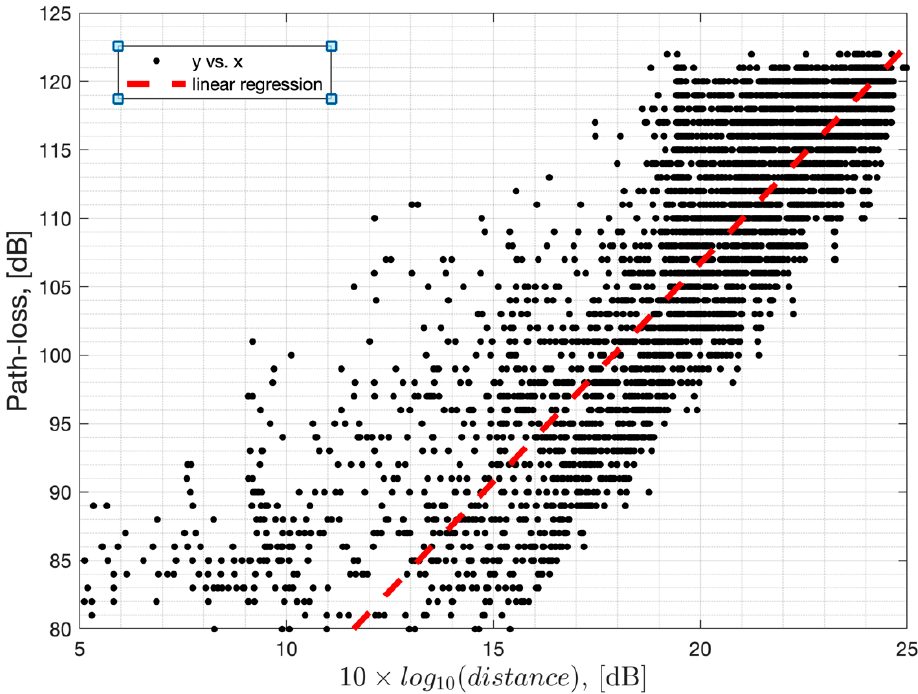
Figure 9. Path loss measurement versus log distance from the GW in a suburban neighborhood in Mountain View, CA, USA.